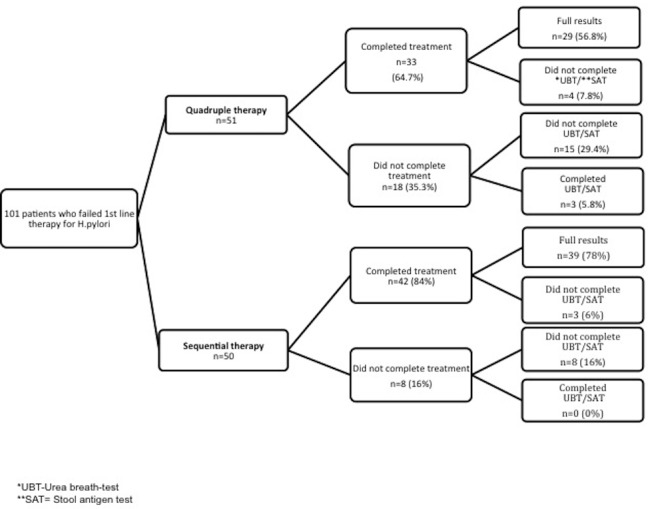
Study flow chart.